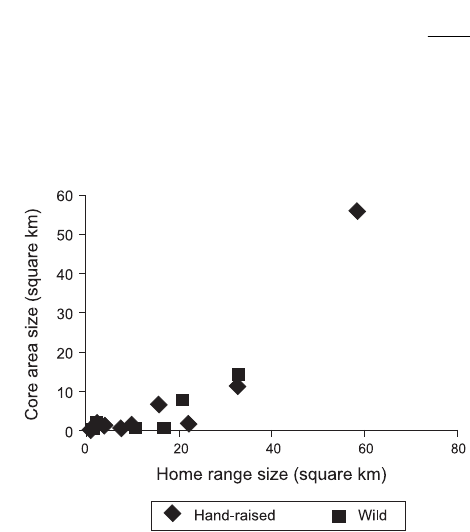
Fig. 8. The relationship between black rhino core area and home range